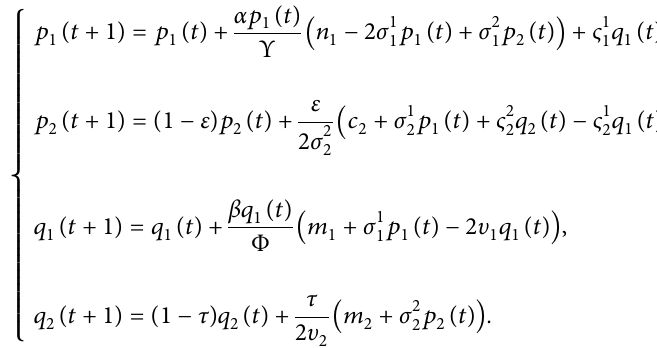
with respect to p t . 1